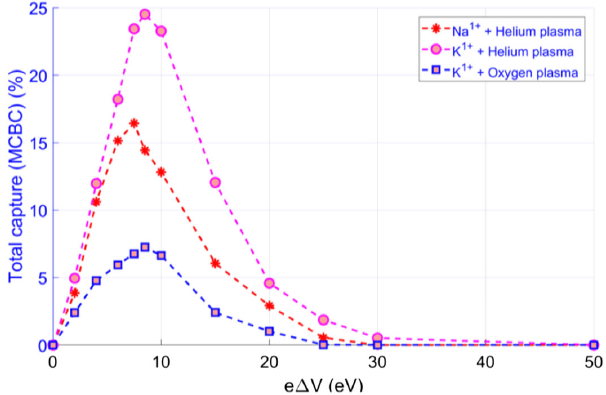
FIG. 13. The estimation of total 1 þ ion capture (in three cases) obtained from MCBC